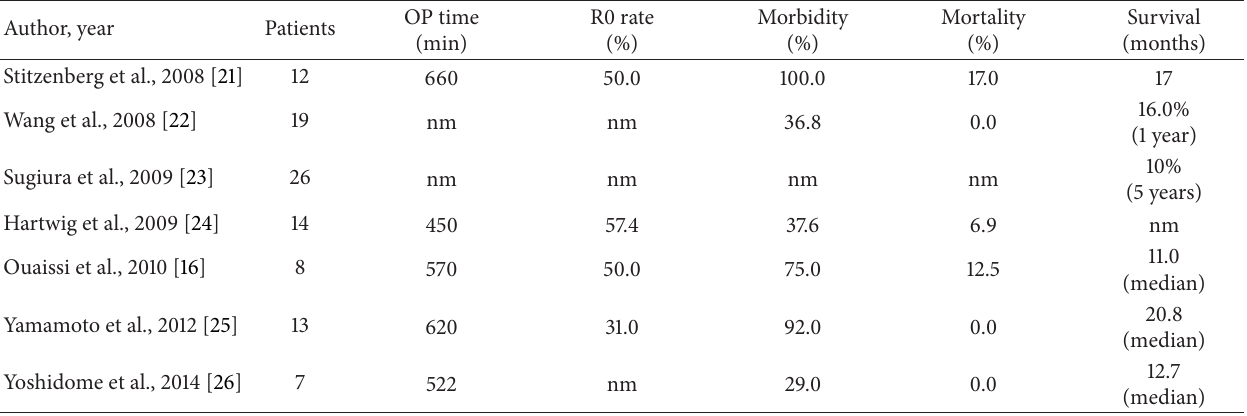
Table 2: Series of arterial resections for pancreatic